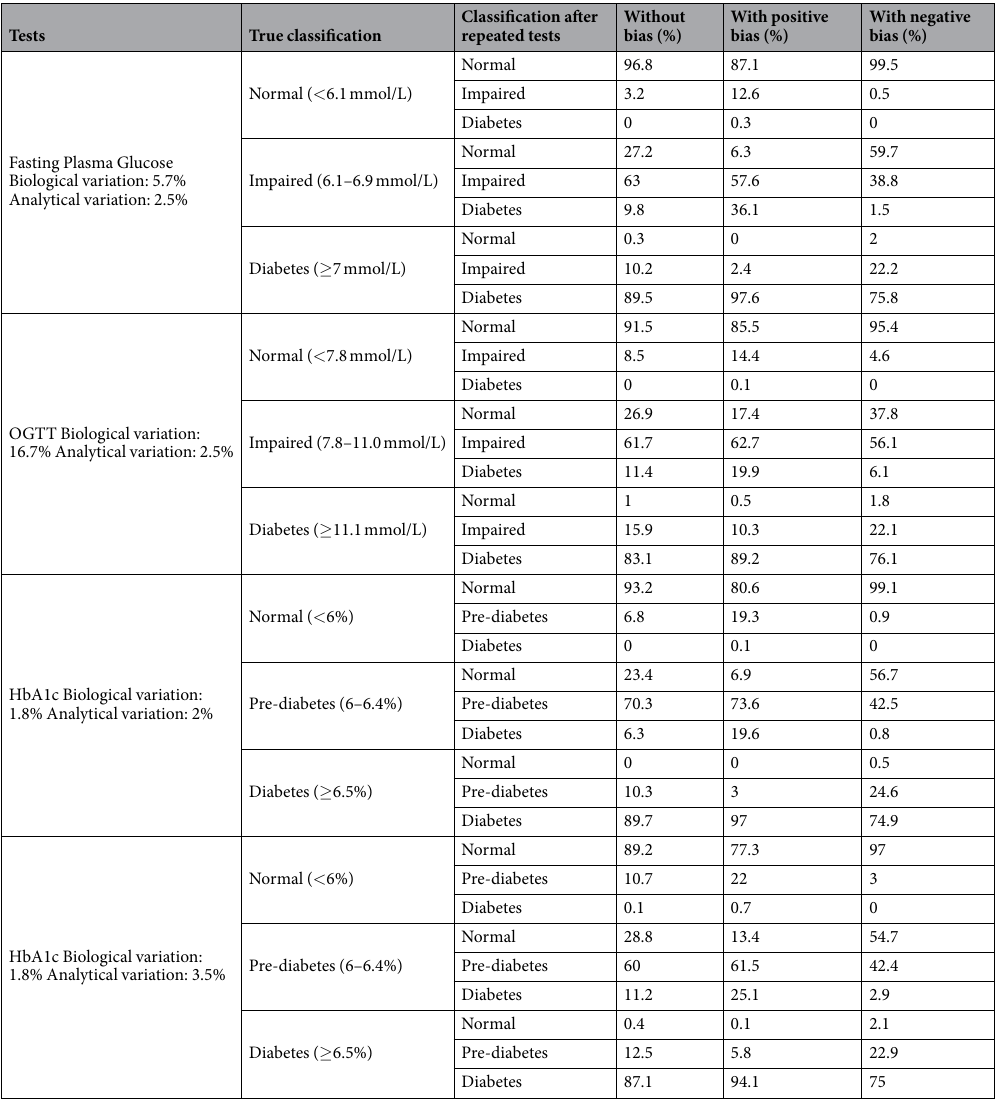
Table 2. Proportion of patients who are misclassified when laboratory testing for diabetes is repeated (World Health Organisation criteria). A between-laboratory positive bias of + 7% and + 2.5% were introduced for the fasting plasma glucose/oral glucose tolerance test, and HbA1c, respectively. A between-laboratory negative bias of − 6% and − 3% were introduced for the fasting plasma glucose/oral glucose tolerance test, and HbA1c,